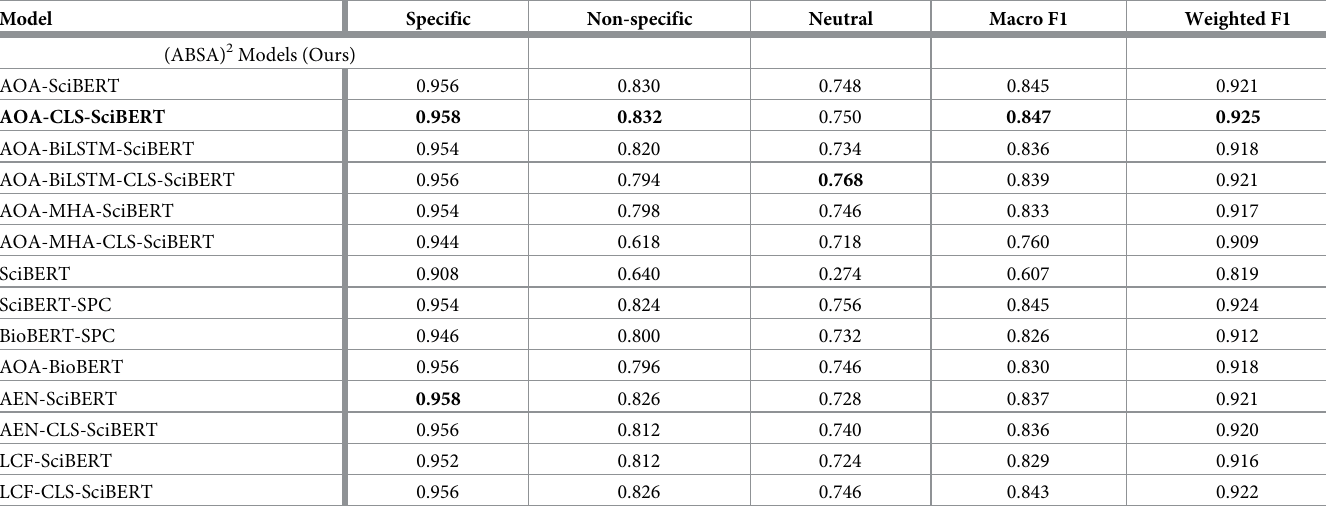
Table 3. Specificity classification performance